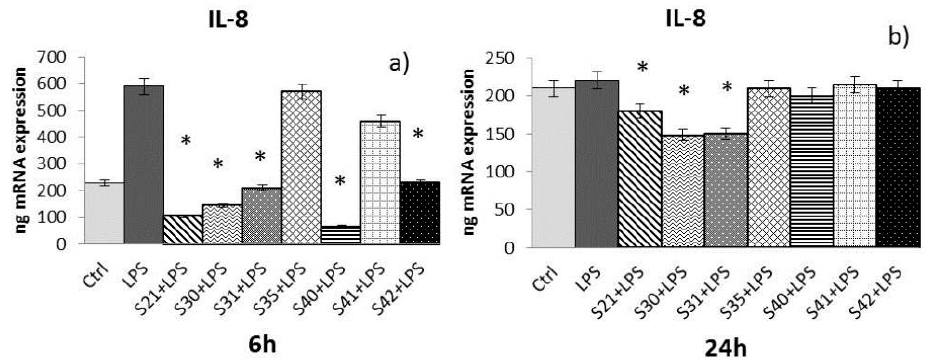
Figure 7. mRNA expression of IL-8 from HaCat cells treated with S21, S30 , S31, S35, S40, S41 and S42 non-woven tissue bio-composites (10 µ g/mL) plus P. aeruginosa lipopolysaccharide (LPS) (10 µ g/mL) 6 h ( a ) and 24 h ( b ). Data are mean ± SD of values calculated on two different experiments. * P < 0.05 compared to LPS (10 µ g/mL)